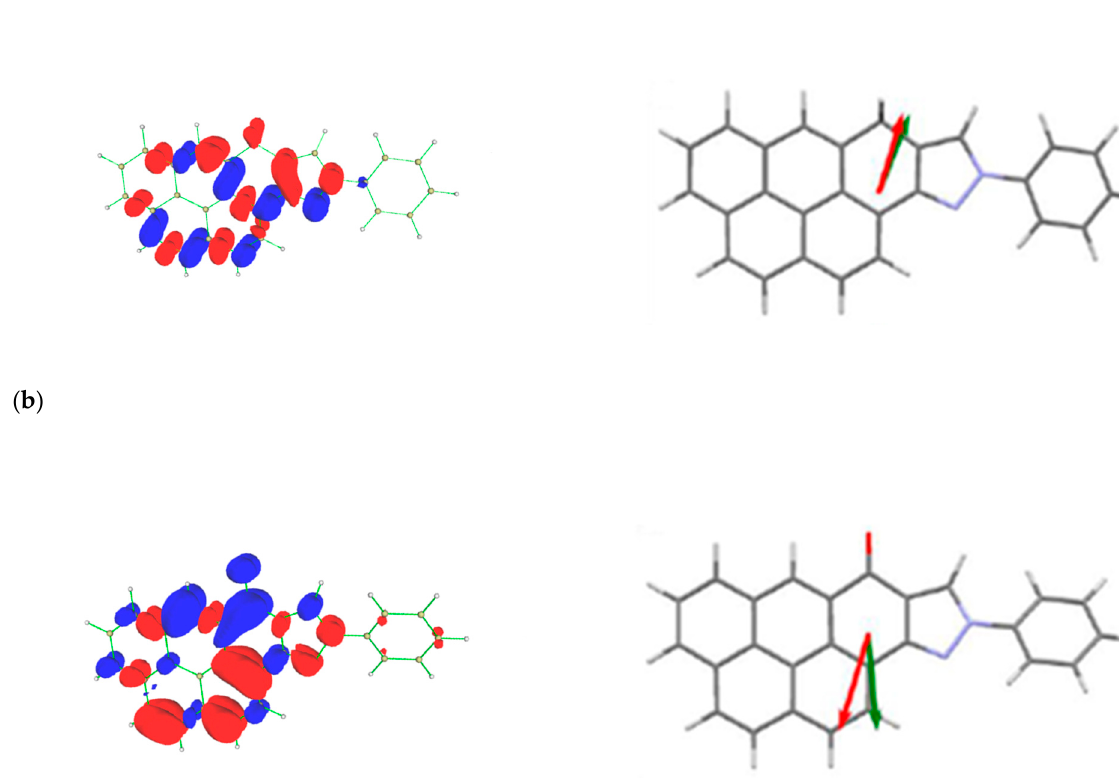
Figure 10. ( Left ) The difference in electron density distribution (regions with increased electron concentration indicated in blue, and decreased electron concentration in red) [29] for the S 0 → S 1 excitation and ( right ) molecular dipole moments for the S 0 (green) and S 1 (red) states of compounds 3 ( a ) and 4 ( b ). Iso-surfaces at ± 0.001 eÅ − 3